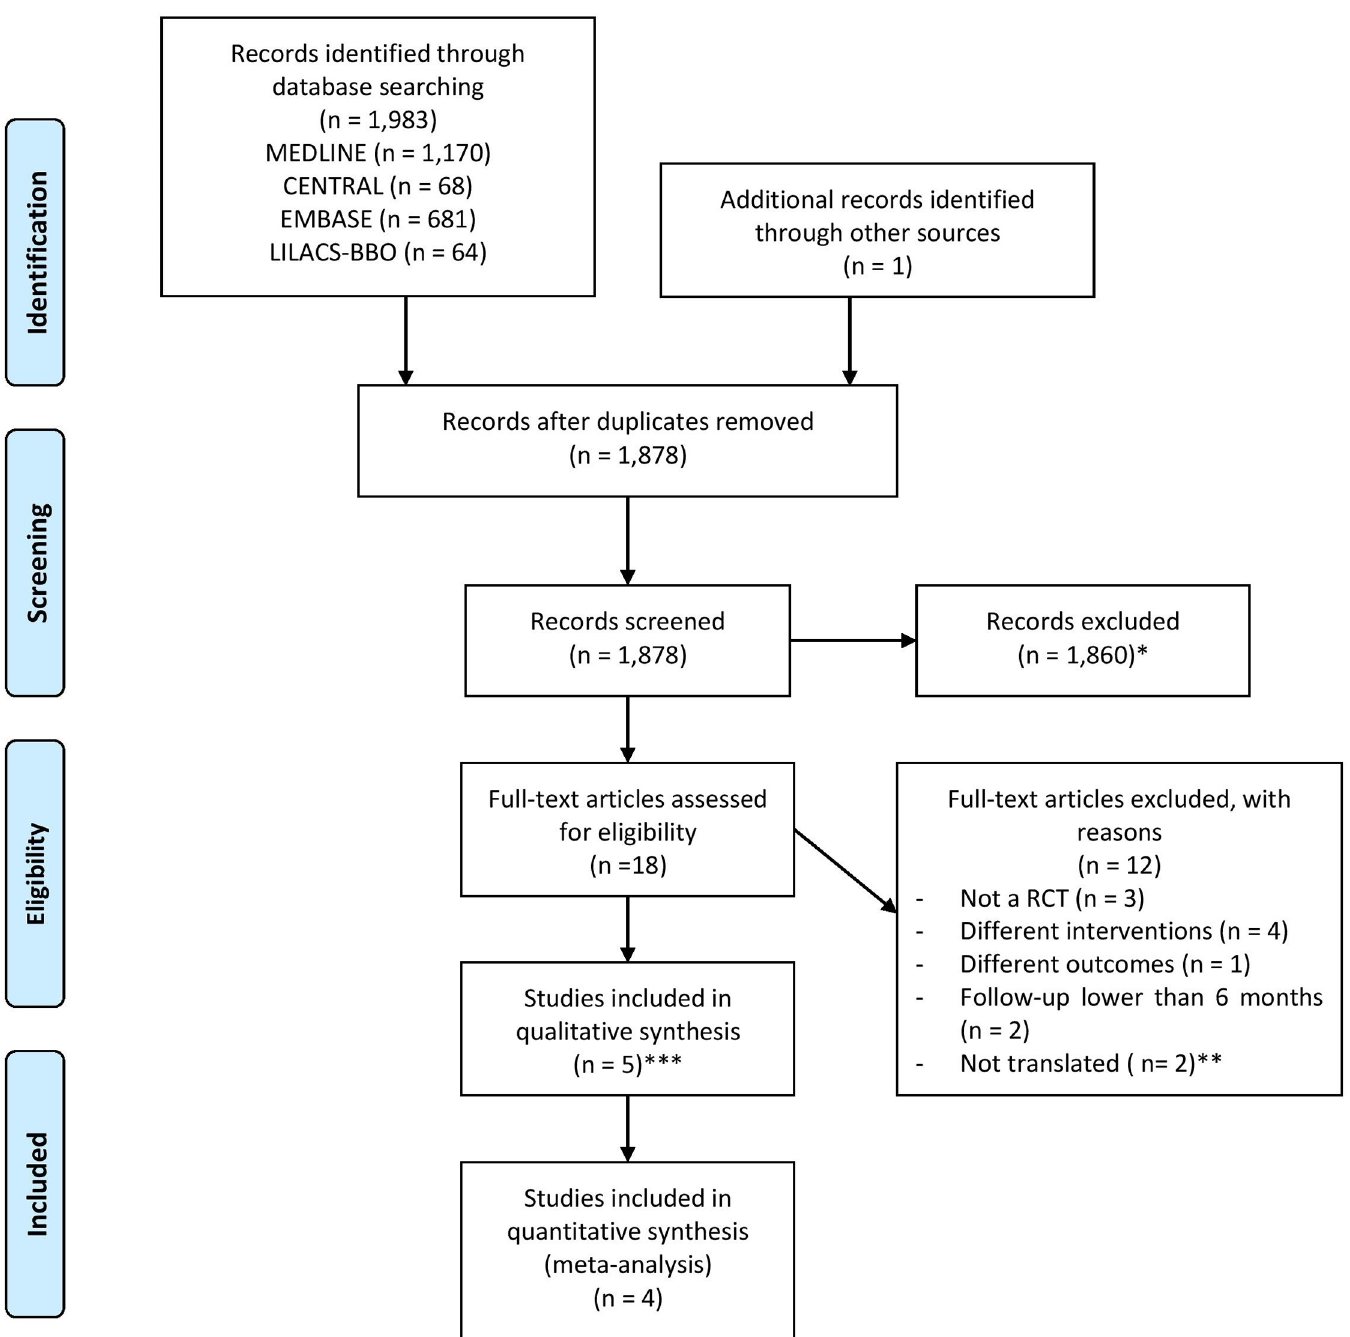
Fig 1. Flow diagram showing the process of identifying, screening, assessing for eligibility, excluding and including the studies retrieved from the electronic and hand searches. * It was not possible to obtain one full-text article and 1,859 did not meet the inclusion criteria. ** One Chinese and one Russian. *** Two articles using the same population were merged and only one article was